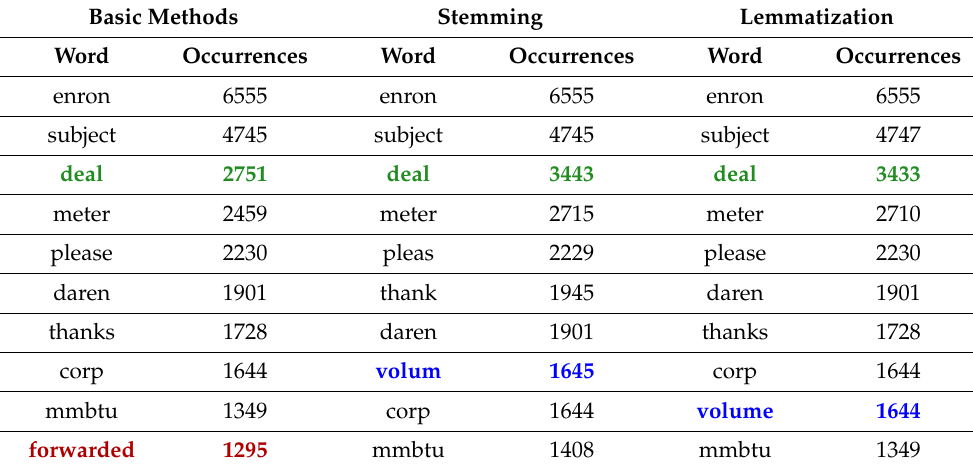
Table 9. Ten most common features for dataset 2.